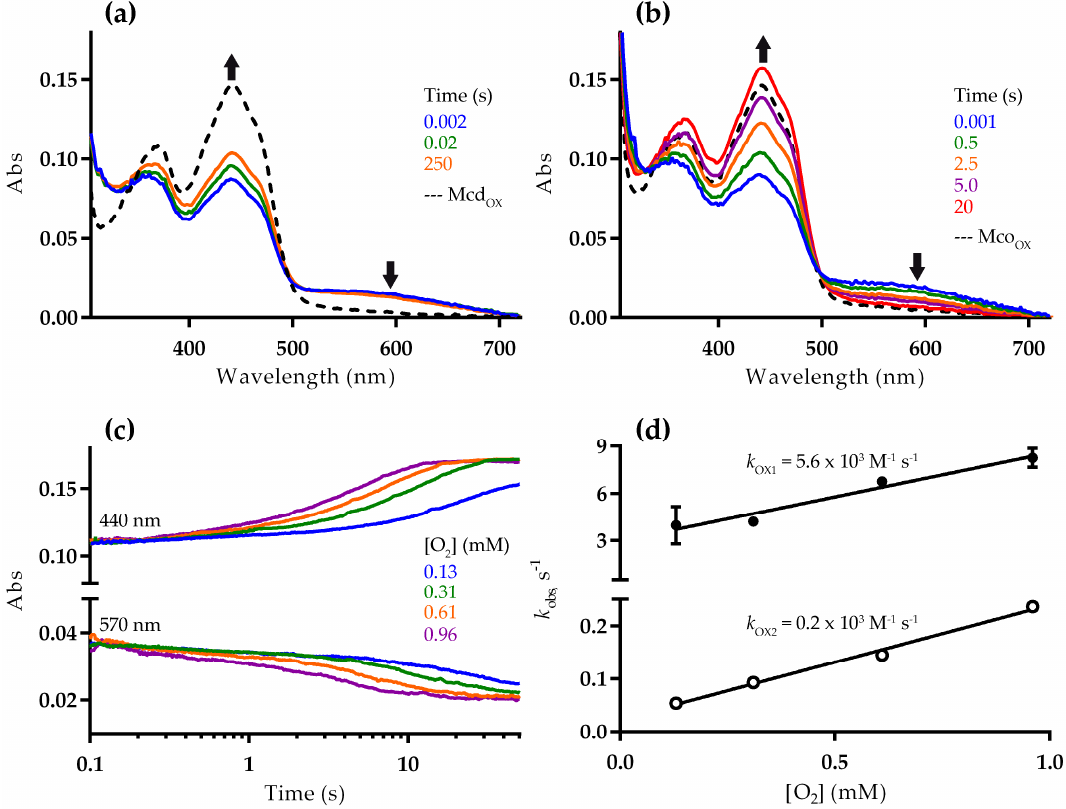
Figure 3. Reaction of reduced Mcd ( a ) and Mco ( b – d ) with dioxygen. Mcd or Mco was partially reduced by adding a stoichiometric amount of ( 2S )-methylsuccinyl-CoA under anaerobic conditions. Subsequently, the partially reduced enzyme was mixed with buffer containing various dioxygen concentrations using a stopped-flow spectrophotometer at 25 °C (0.13, 0.31, 0.61, and 0.96 mM dioxygen in the stopped-flow cell); ( a , b ) spectral changes showing Mcd ( a ) and Mco ( b ) re-oxidation with 0.96 mM dioxygen, as well as the spectrum of the fully-oxidized enzyme (broken line). Differences observed among the spectrum of the fully oxidized Mco and that of the re-oxidized Mco (20 s, red line) may due to the presence of product bound to re-oxidized enzyme (Figure S6) [18]; ( c ) stopped-flow traces recorded during Mco re-oxidation; and ( d ) stopped-flow traces at 440 nm were fit to a double exponential function to obtain the k obs values versus dioxygen concentration.